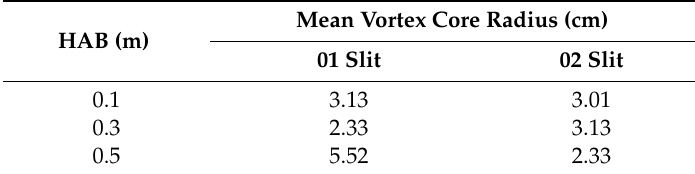
Table 2. Mean vortex core radius at three monitoring HABs: 01 slit case and 02 slit case.